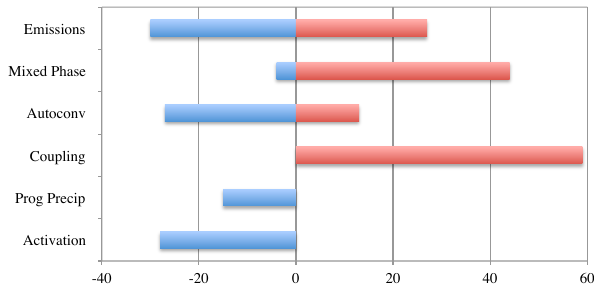
Figure 10. Percent change in ACI for different dimensions of sen- sitivity tests as described in the